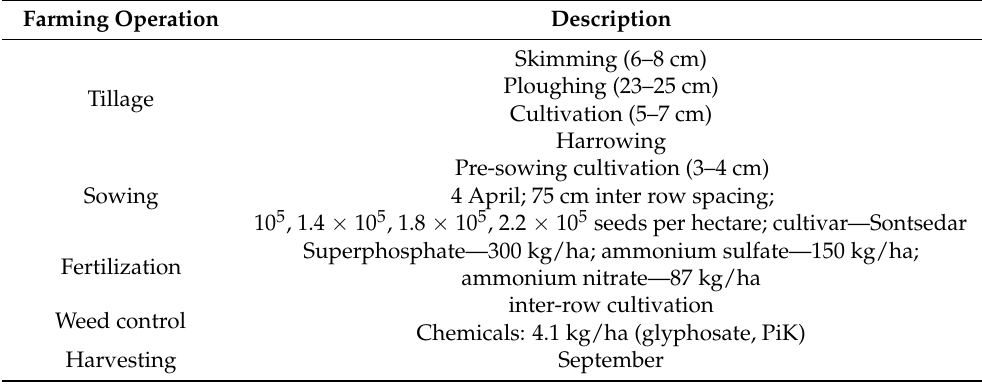
Table 2. Production of grain